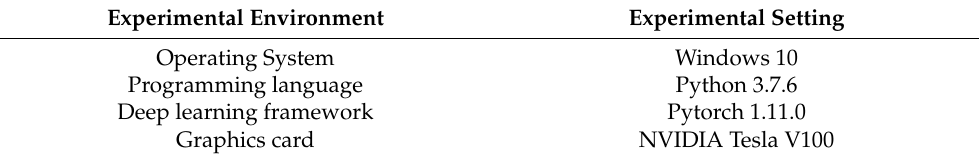
Table 3. Experimental environment.